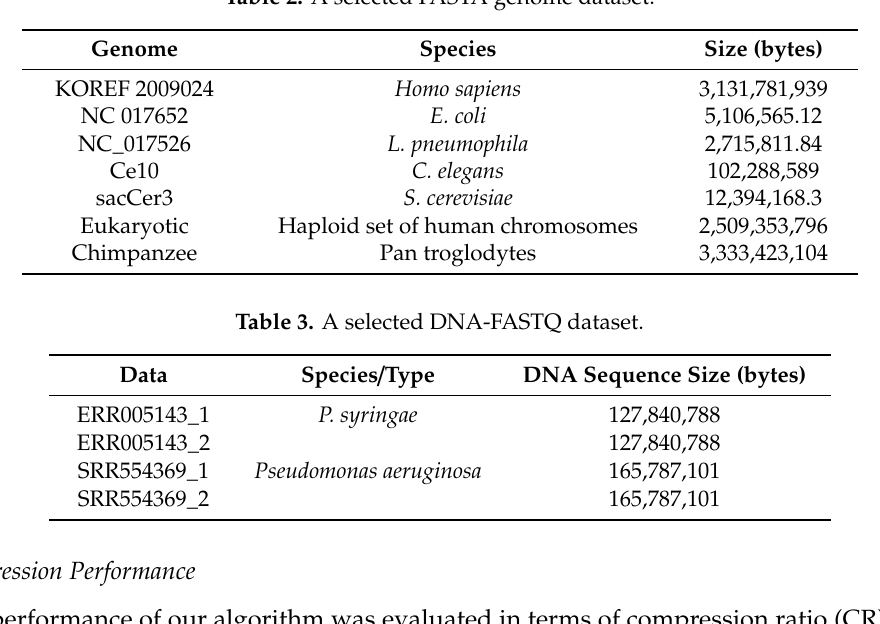
Table 2. A selected FASTA genome dataset.